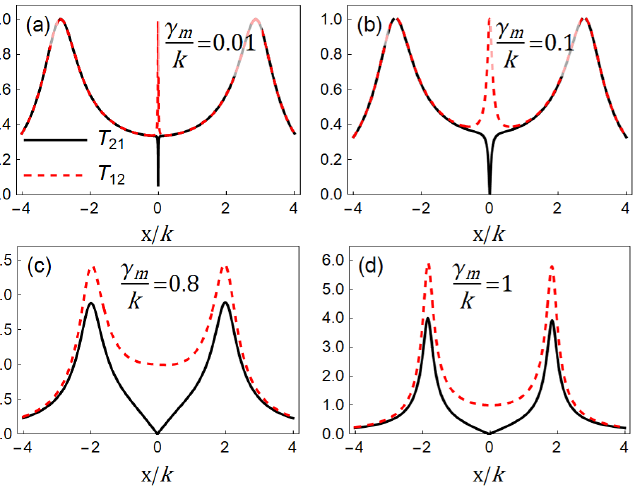
(cid:0) ∆ (cid:48) = − (cid:1) 2 ω m , transmission amplitudes (cid:4666)(cid:1876) ＝ (cid:2012) (cid:3397) ( x = δ + 2 ω m ) (cid:3038) k